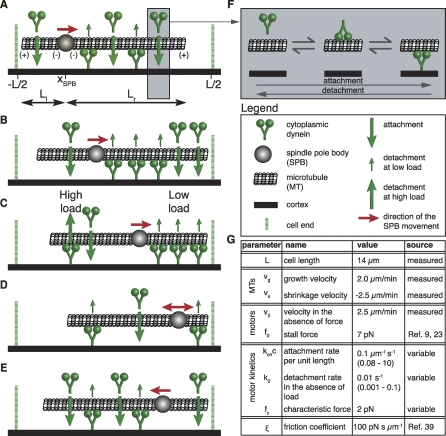
The Minimal Model(A–D) Schematic drawing of events during oscillations. (A) The position of the SPB along the cell longitudinal axis is denoted x
SPB. The two cell ends are located at x = −L/2 and x = L/2, respectively, where L is the cell length. Two microtubules grow from the SPB. There are more motors attached to the microtubule on the right, thus the SPB moves to the right. As the SPB moves, the motors on the left microtubule are under high load, which stimulates their detachment. The load on the motors on the right microtubule is low. The asymmetry in the number of motors on the two microtubules grows, resulting in a faster SPB movement.(B) The faster movement further increases the asymmetry in the load on the motors, creating a positive feedback between the SPB movement and the number of motors.(C) However, because of the finite size of the cell, the right microtubule shrinks and thus loses motors.(D) When the number of motors on the left and the right microtubule is equal, the SPB does not move. Since the left microtubule is longer than the right one, it accumulates more motors.(E) Thus, the SPB changes direction and the oscillation cycle continues.(F) Steps in the dynein attachment and detachment process; the intermediate step is not included in the model (Text S1, I.F).(G) Parameters of the model. The values in brackets denote the intervals where the behavior of the model does not change. υ0 was estimated as the maximum SPB velocity (Figure S7; Text S1, Tables SI–SIII); experimentally measured values of υg, υs, υ0 for the strain used in Figures 2, 3A, and 5D–5F are shown in Text S1, Table SII.